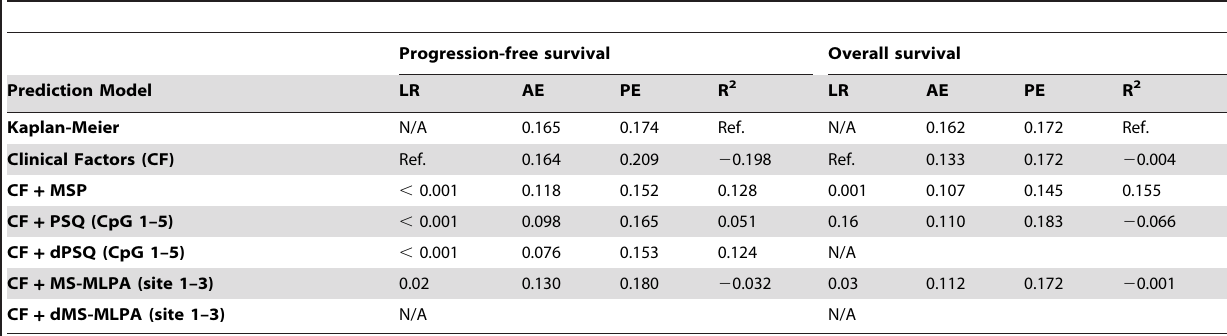
Table 3. P values of likelihood ratio tests (LR; clinical vs. clinical plus methylation data), apparent error (AE), 10-fold cross-validated prediction error (PE), and explained variation R 2 (PE based R 2 value), computed for 18-months